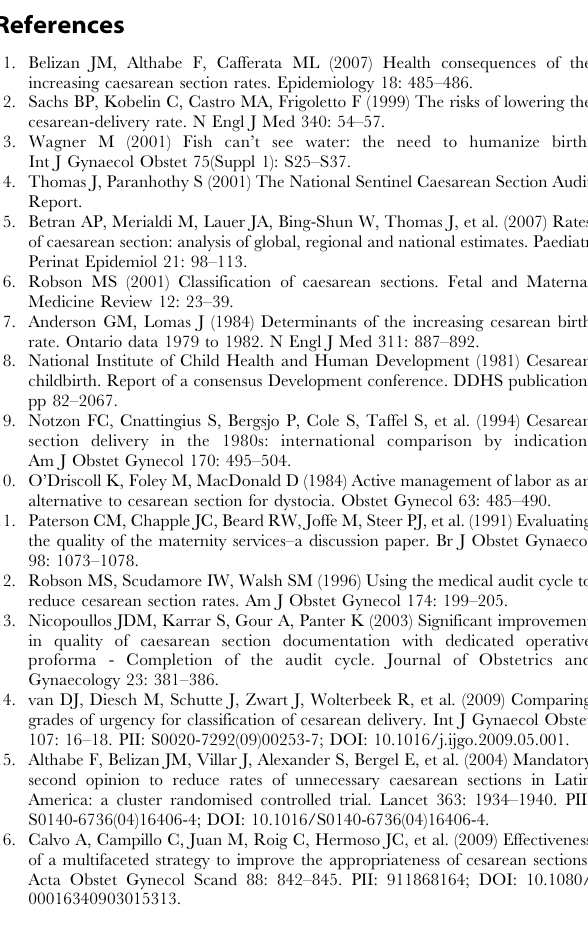
Figure S3 Data extraction form used to analyse and critically appraise existing Cesarean section classifications.